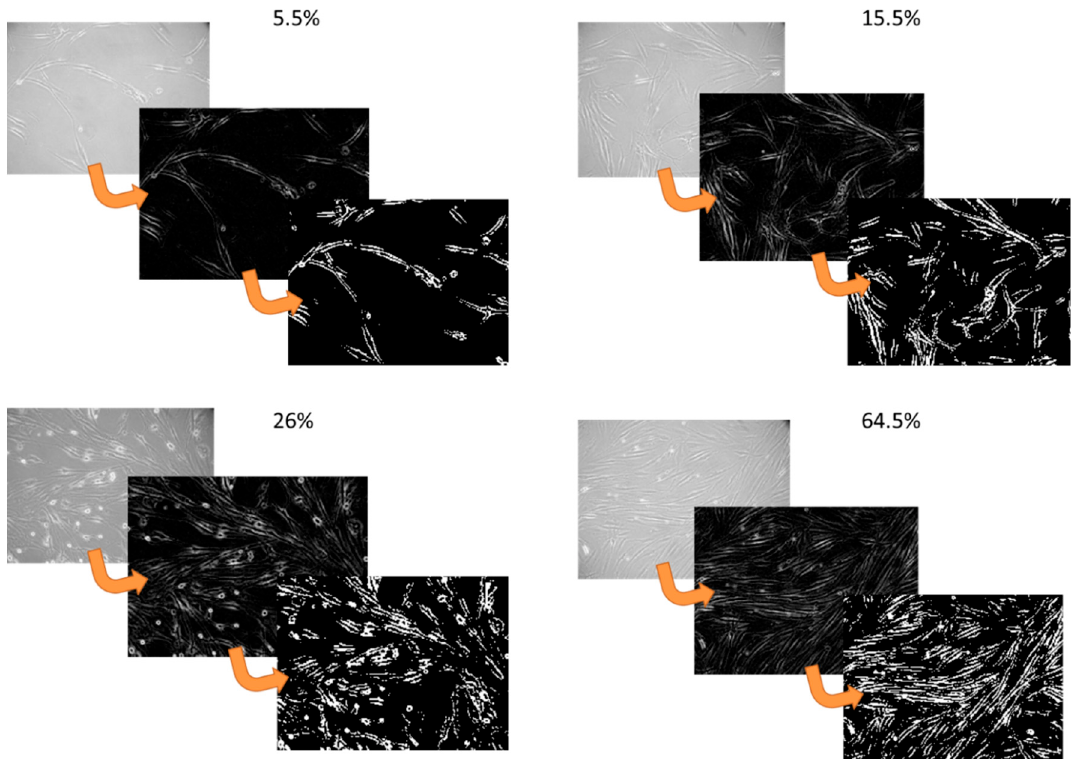
Figure 3. A demonstration of image processing by top hat transformation and thresholding segmentation for different cell confluence levels.